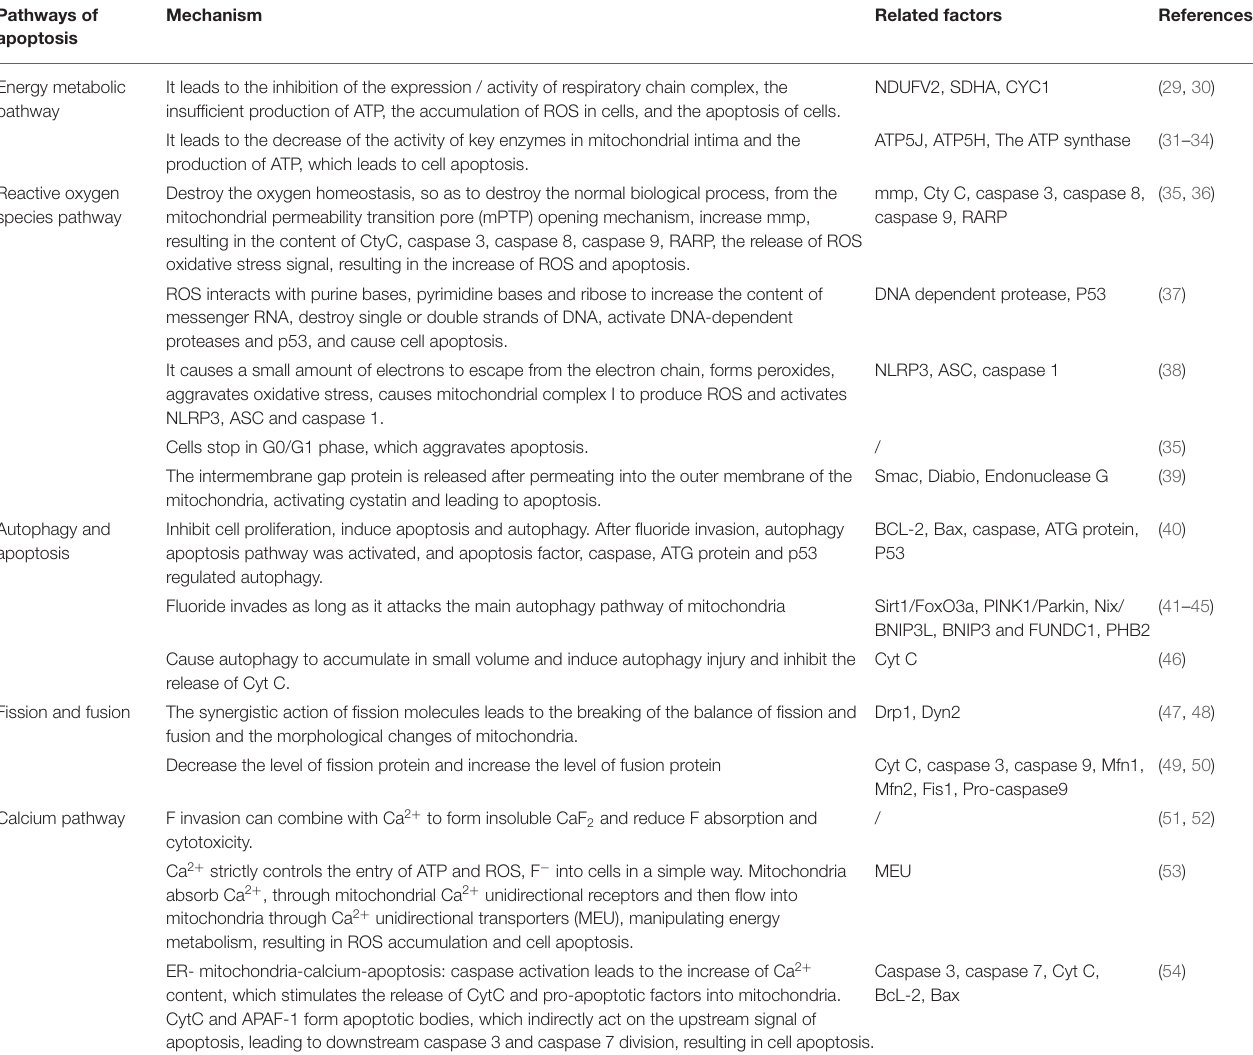
TABLE 1 | Apoptosis mechanism related to mitochondrial disturbance caused by